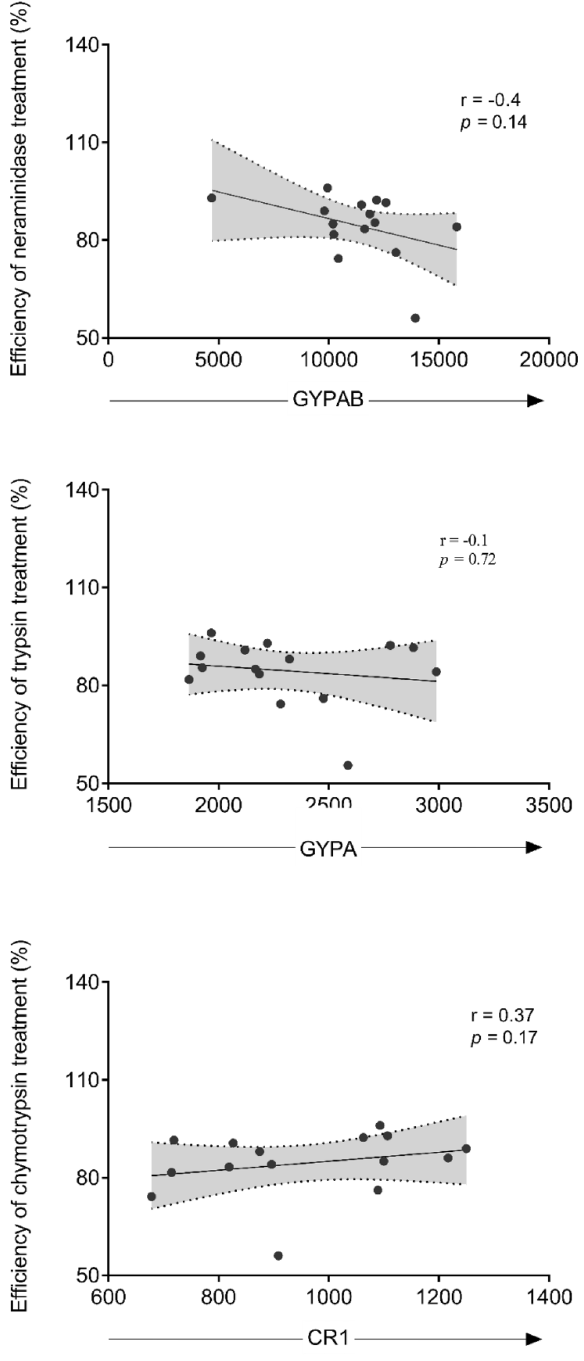
Figure 5. Correlation of erythrocyte receptor densities with the efficiency of enzyme treatment. The density of erythrocyte surface receptors, labelled with specific monoclonal antibodies prior to, and following enzyme treatment was quantified by flow cytometry using fluorescently labelled secondary antibodies. The efficiency of enzyme treatment was then expressed as follows: 100 – (MFI Treated Erythrocytes/MFI Control Erythrocytes × 100). Experiments were performed in triplicates and the resulting data were analysed with FlowJo v.10.01 and the Spearman R correlation were performed using Graph Pad Prism